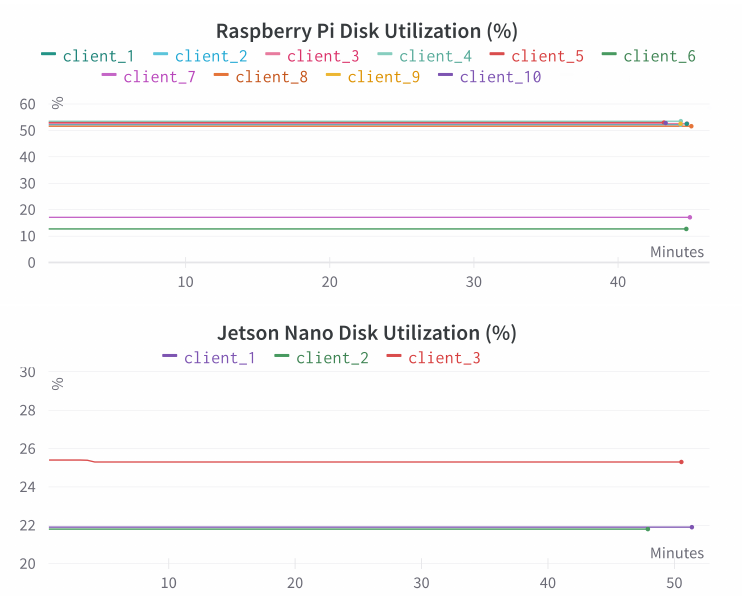
Figure 9. Disk utilization comparison for different Raspberry Pi and Jetson Nano devices. The x-axis represents the time in minutes, the y-axis represents the disk utilization percentage (%).